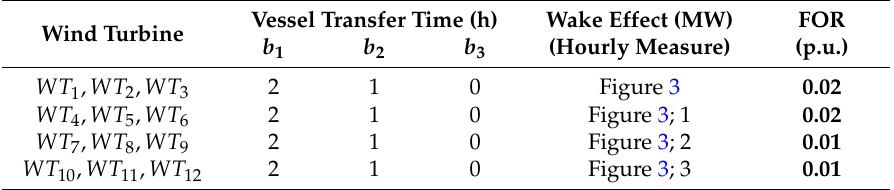
Table 2. Vessel transfer time, wake effect and forced outage rate (FOR).